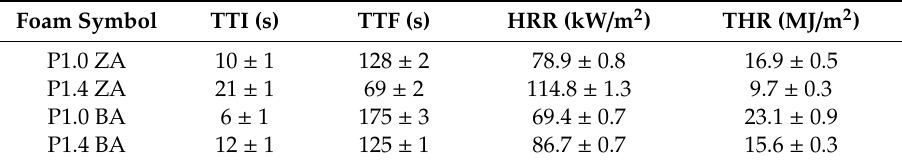
Table 5. Fire properties of selected RPU / PIR foams.